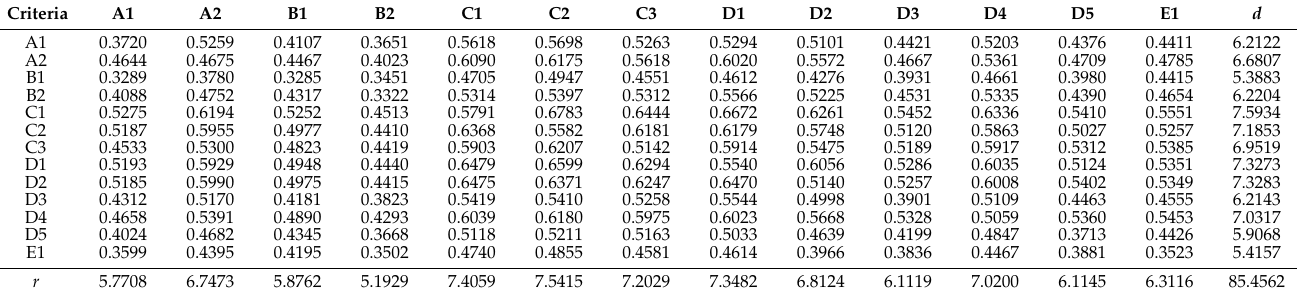
Table 6. Total influence relationship matrix established according to the criteria.